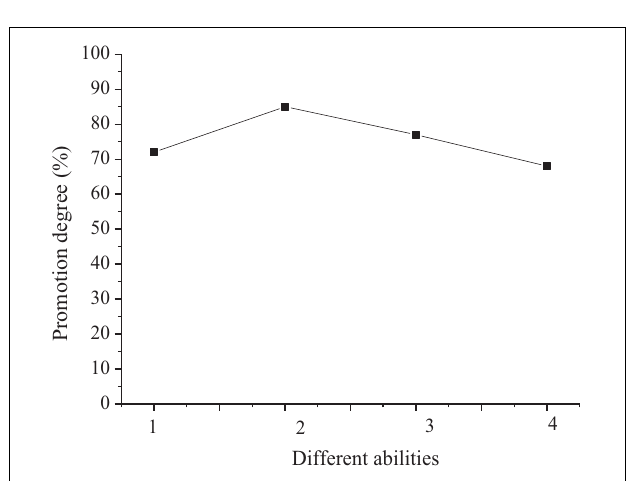
FIGURE 10 | Feedback of parents on the intelligent piano course (1, the ability of children to read music; 2, the improvement of interest of children; 3, piano playing ability of children; 4, solfeggio ability of